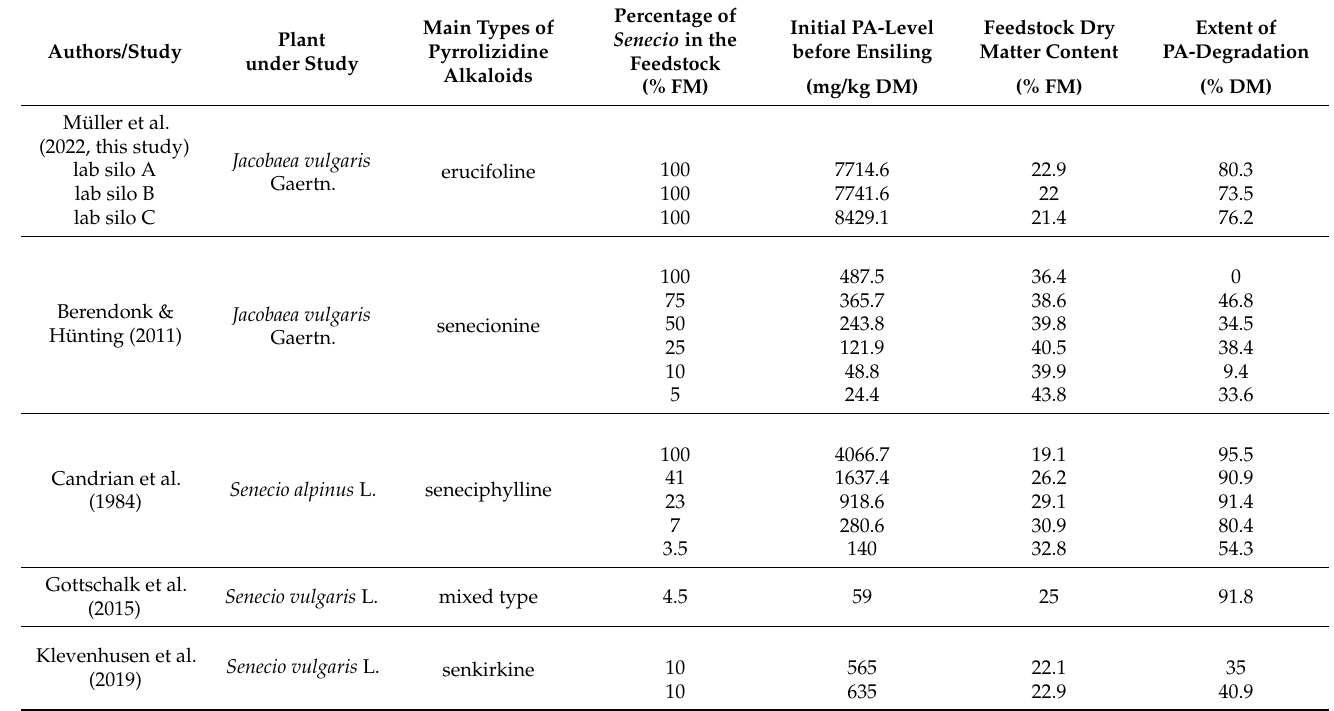
Table A1. Summary of PA/PANO-degradation studies on PA-containing Jacobaea / Senecio species. The tabulated data matches the data shown in Figure 3 of the